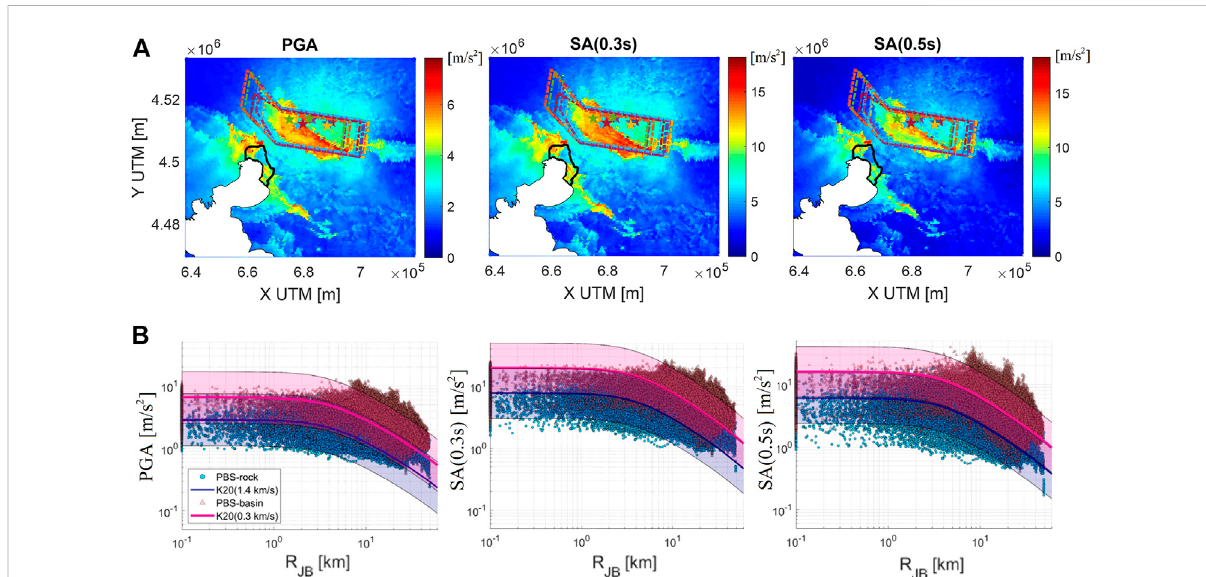
FIGURE 12 (A) Broadband simulated maps of median horizontal PGA, SA (0.3 s) and SA (0.5 s) for the 10 M W 7 GER-LAN scenarios. (B) Simulated spectral accelerationsasafunctionofdistance(R JB )incomparisonwiththeempiricalGMMbyKothaetal.,2020(K20)atbothrock(blue)andbasin(magenta)